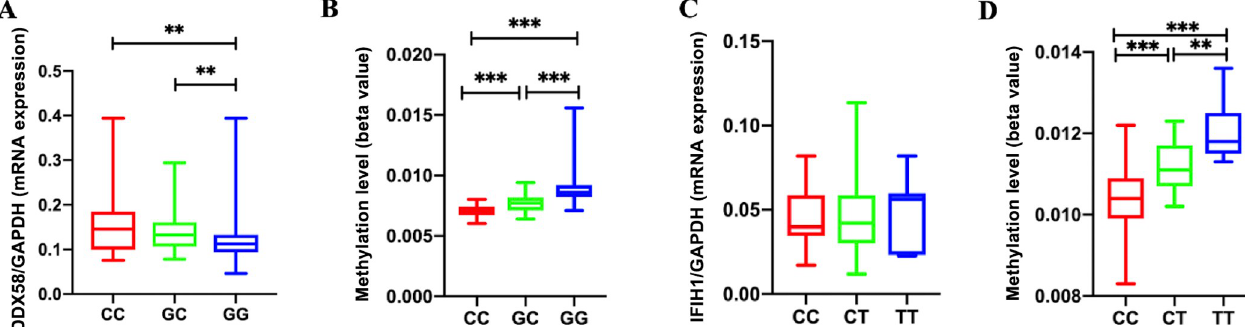
Fig 6. DDX58 expression levels in each genotype at polymorphic sites (A). DDX58 methylation levels in each genotype at polymorphic sites (B). IFIH1 expression levels in each genotype at polymorphic sites (C). IFIH1 methylation levels in each genotype at polymorphic sites (D) �� p < 0.01, ��� p <